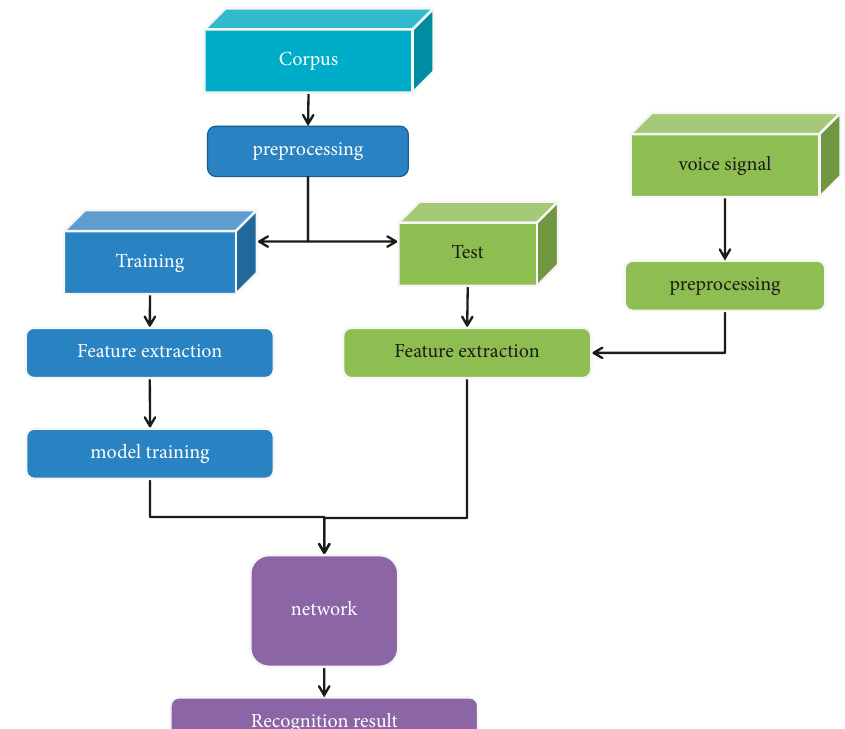
Figure 1: Speech emotion recognition process.